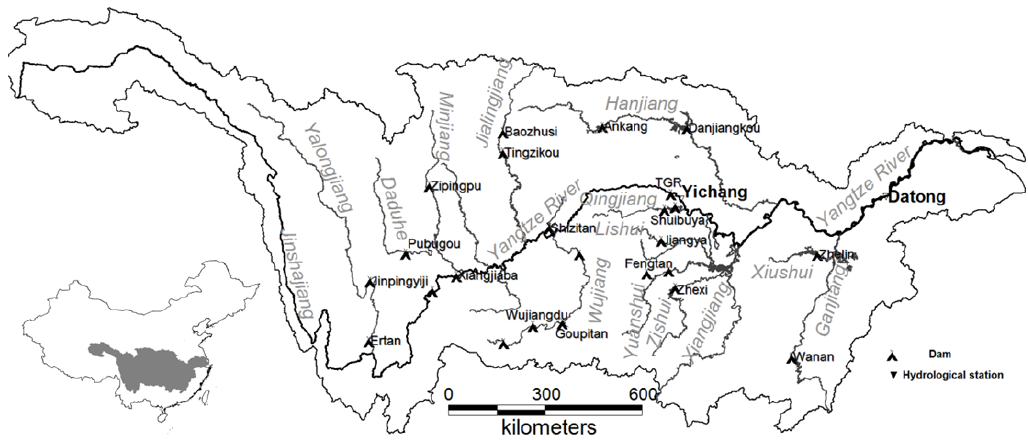
Figure 1. Hydrological stations and large (the total storage is larger than 100 million m 3 ) reservoirs in the Yangtze River basin. the Yangtze River